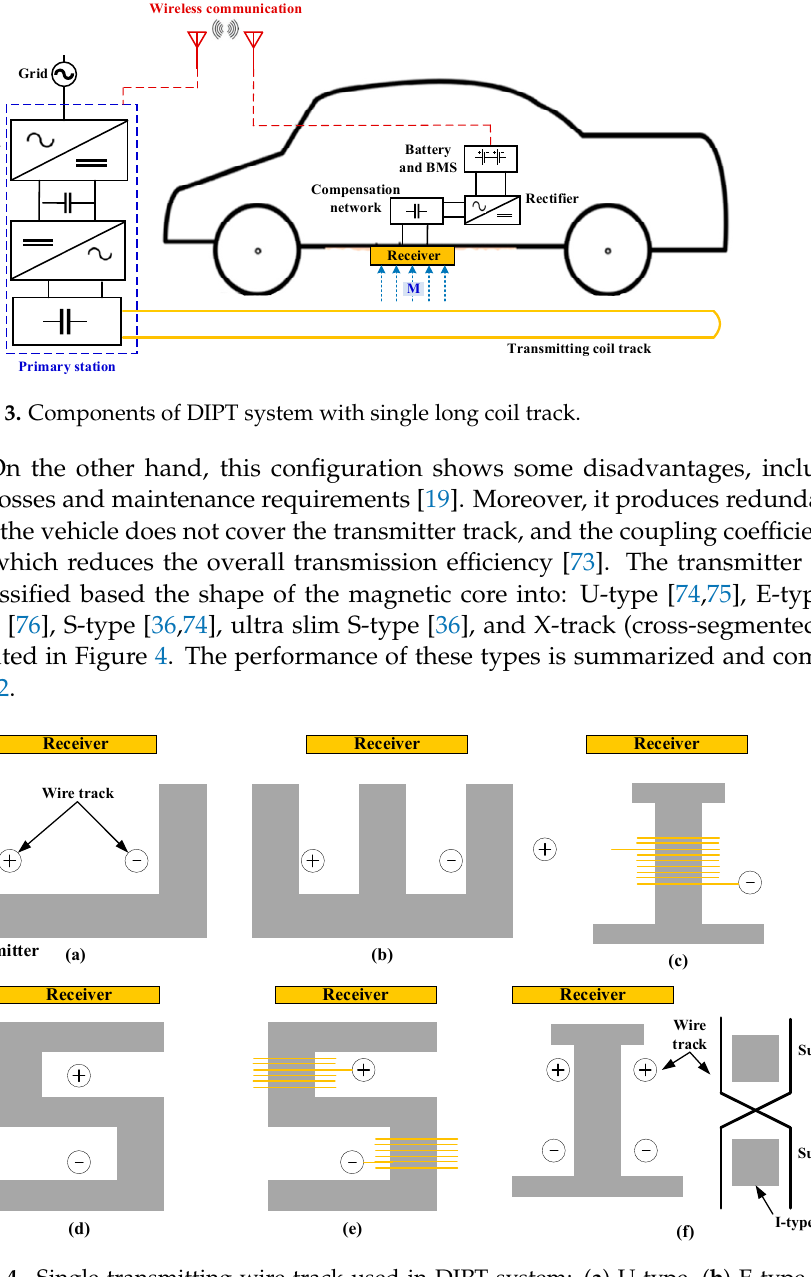
Figure 4. Single transmitting wire track used in DIPT system: ( a ) U-type, ( b ) E-type, ( c ) I-type, ( d )